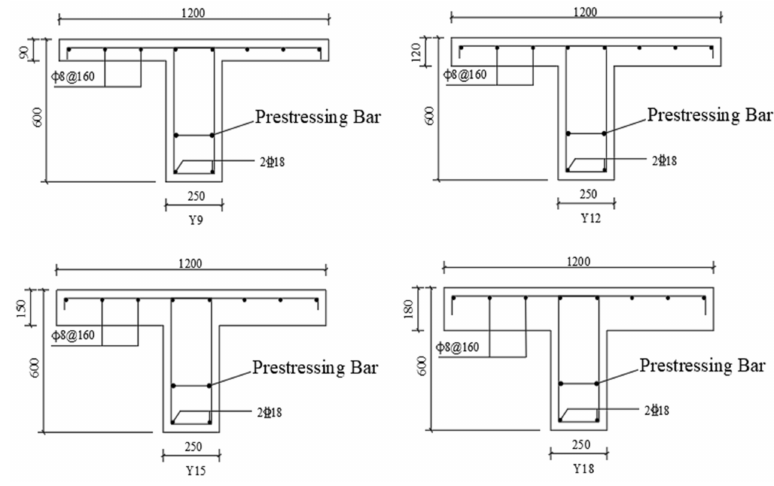
Figure 7. Dimensions and reinforcement of prestressed concrete T-beam.